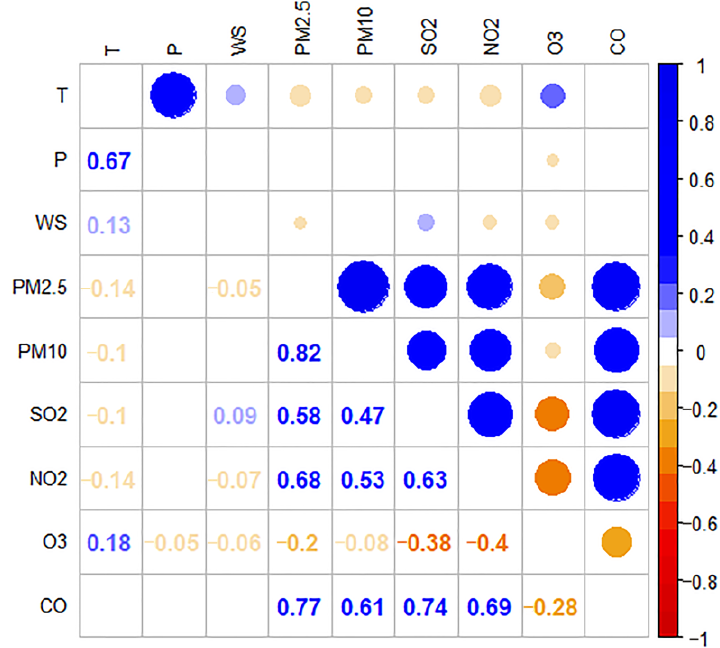
Figure 7. Correlation between pollutants and meteorological elements.